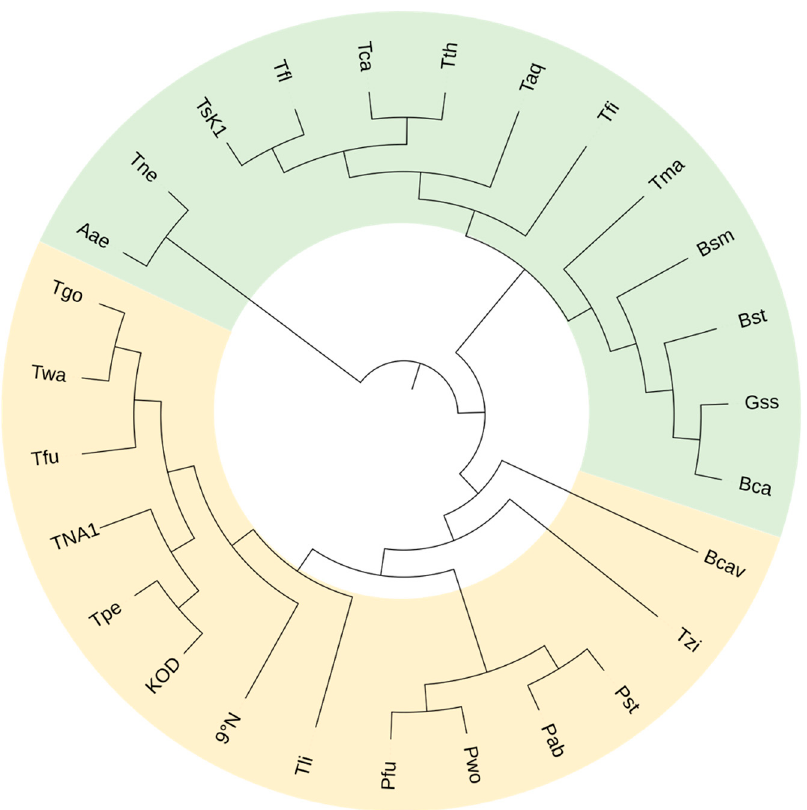
Figure 1. Phylogenetic tree of representative thermophilic DNAPs. Green: family A DNAPs; pale yellow: family B DNAPs.